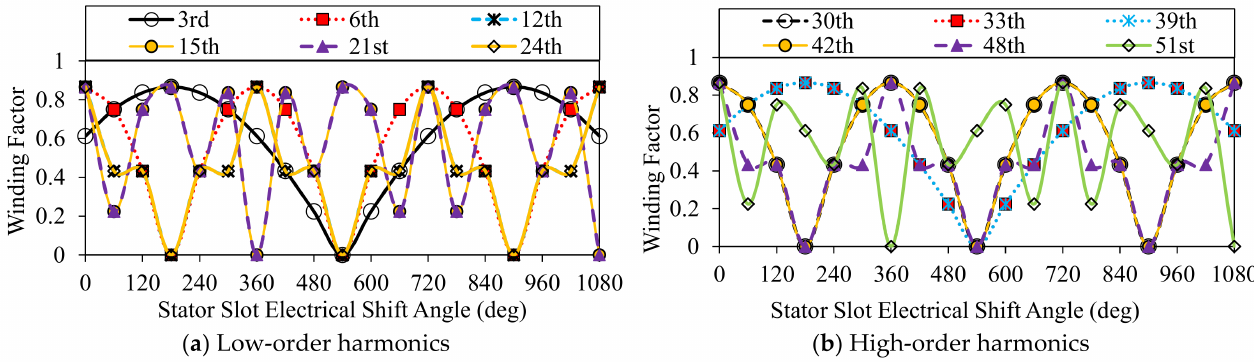
Figure 7. Variation of low-order ( a ) and high-order ( b ) harmonics with respect to shift angle α while the winding set polarizations are ( + , − ).